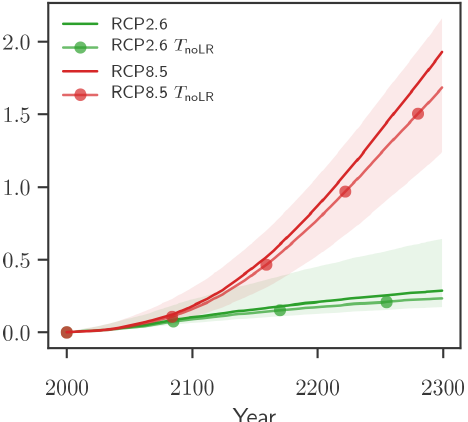
Figure C1. Impact of the melt–elevation feedback. PISM-dEBM- simple simulations of the Greenland Ice Sheet with RCP2.6 (green lines) and RCP8.5 (red lines) warming. Dark solid lines take the melt–elevation feedback through the atmospheric temperature lapse rate into account. Shaded lines with markers neglect the melt– elevation feedback and assume a zero atmospheric temperature lapse rate. Ice loss is given in metres of sea level equivalent. A value of 1ms.l.e. corresponds to approx. 361800Gt of ice.